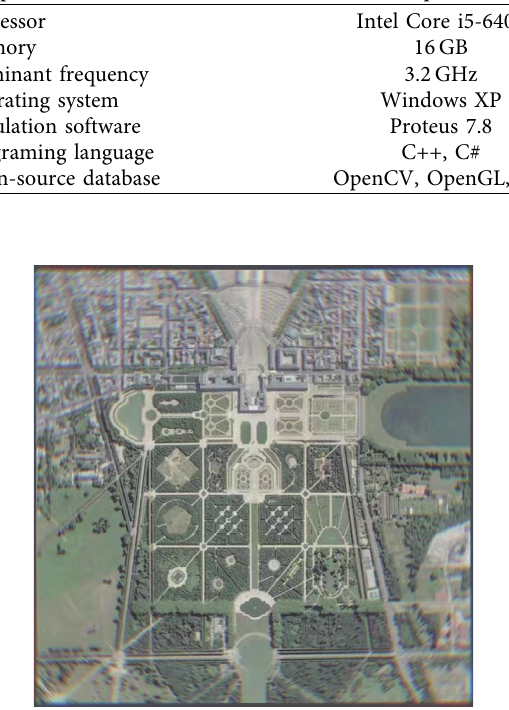
Figure 1: Experimental